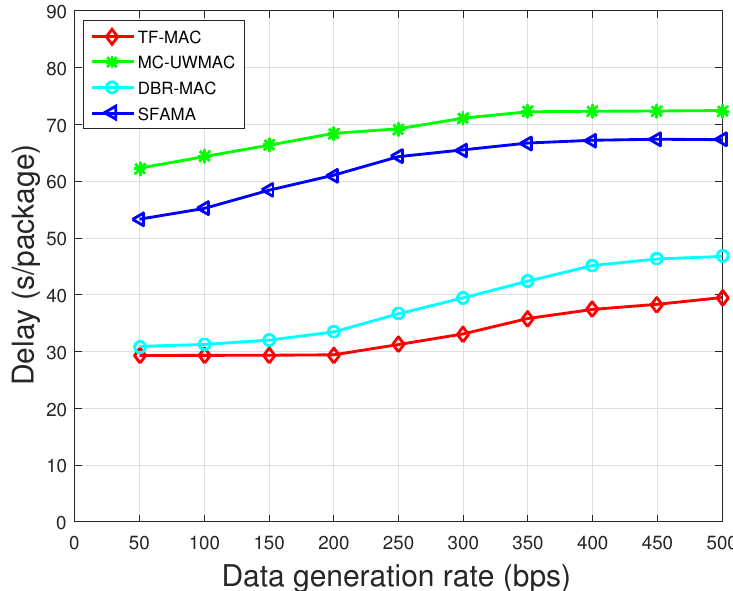
Figure 16. Comparison of end-to-end delay in the dense